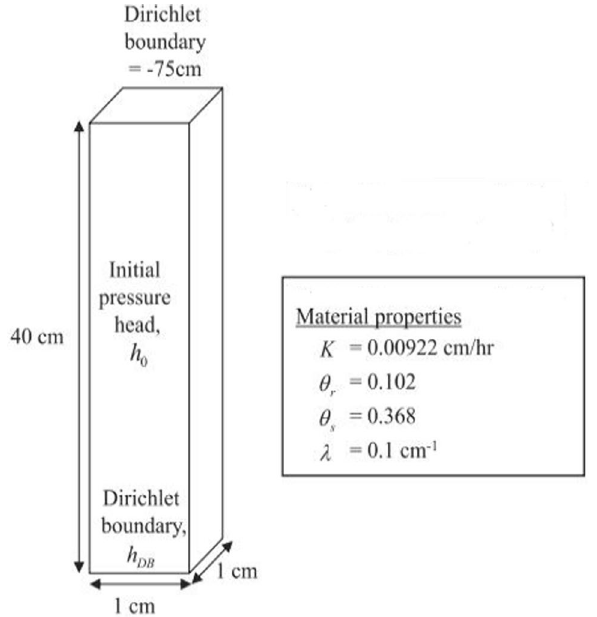
Fig. 4 Domain of interest, initial and boundary conditions (Suk and Park 2019)